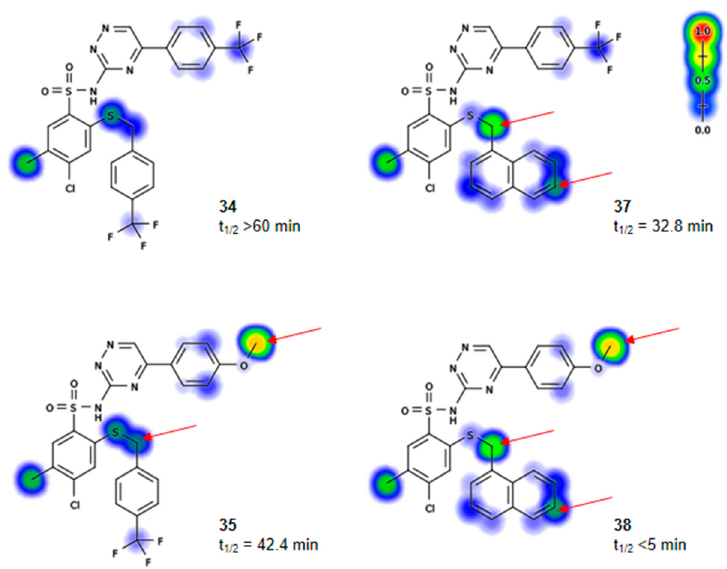
Figure 8. Sites of metabolism predicted for 34 , 35 , 37 and 38 by XenoSite software [42]. Yellow color indicates more vulnerability to biotransformation than blue. Some significant differences are additionally pointed out by red